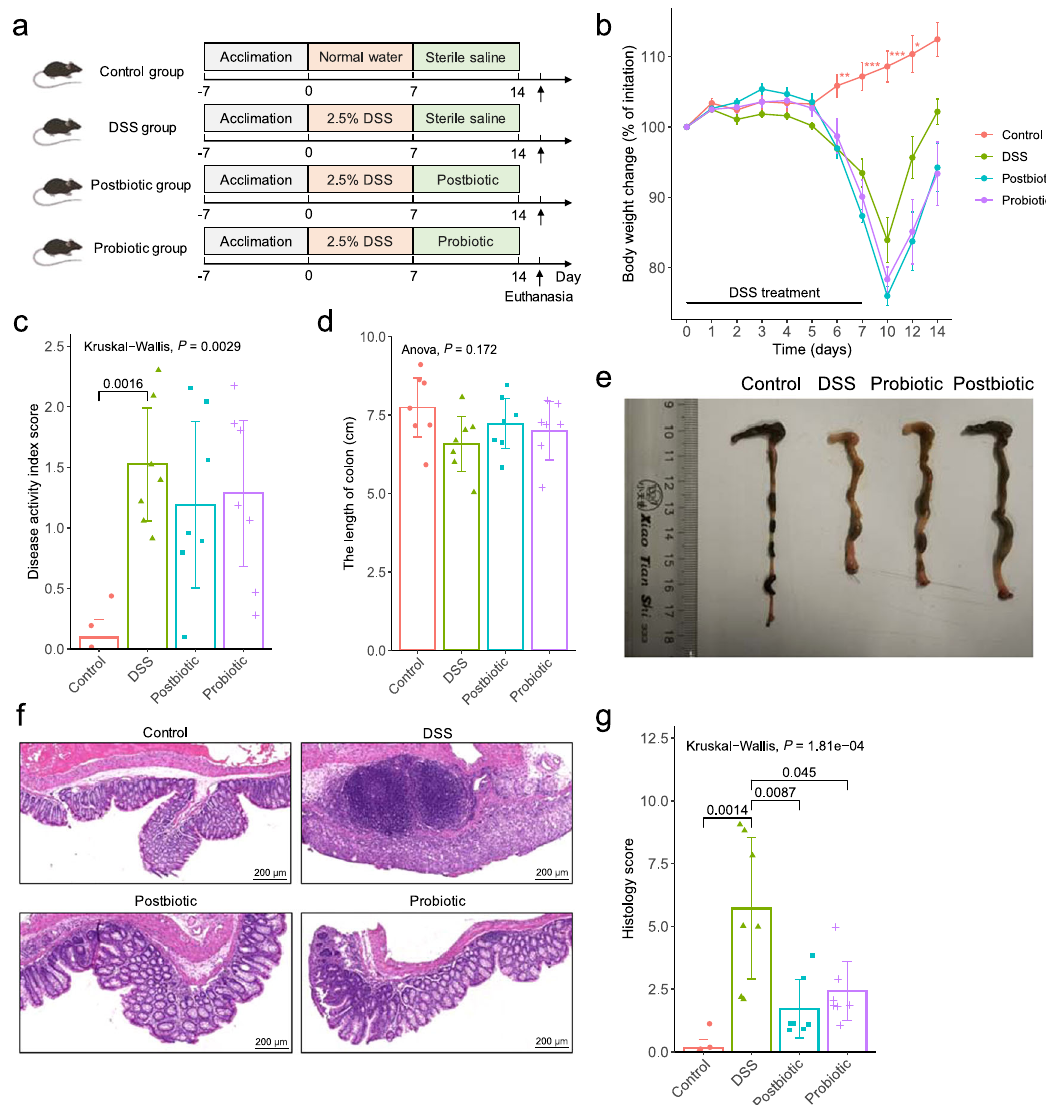
Fig. 1 Both postbiotics and probiotics administration attenuated DSS-induced experimental colitis. a Schematic illustration of the experimental design. The animal trial was performed with male speci fi c pathogen-free C57BL/6 J mice ( n = 7 per group). All mice were acclimatized for a week prior to ulcerative colitis induction by providing dextran sulfate sodium (DSS) in drinking water. After acclimatization, the groups were randomized into four groups: Control, DSS, Postbiotic, and Probiotic, for respective interventions. b Body weight change of mice in the animal trial. c Disease activity index (DAI) scores at the end of the animal trial. d Colon length at the end of the animal trial. e Representative pictures of colon morphology of mice from the four treatment groups. f Representative micrographs of colon tissue sections of four groups of mice. g Histological scores of colon at the end of the animal trial. The error bars on the line and bar charts represented the standard deviations. The scale bar of representative images is ×40 by 200 μ m. * P < 0.05, ** P < 0.01, *** P <